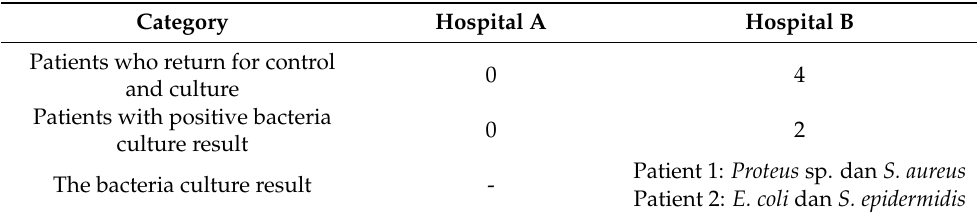
Table 5. The incidence of surgical site